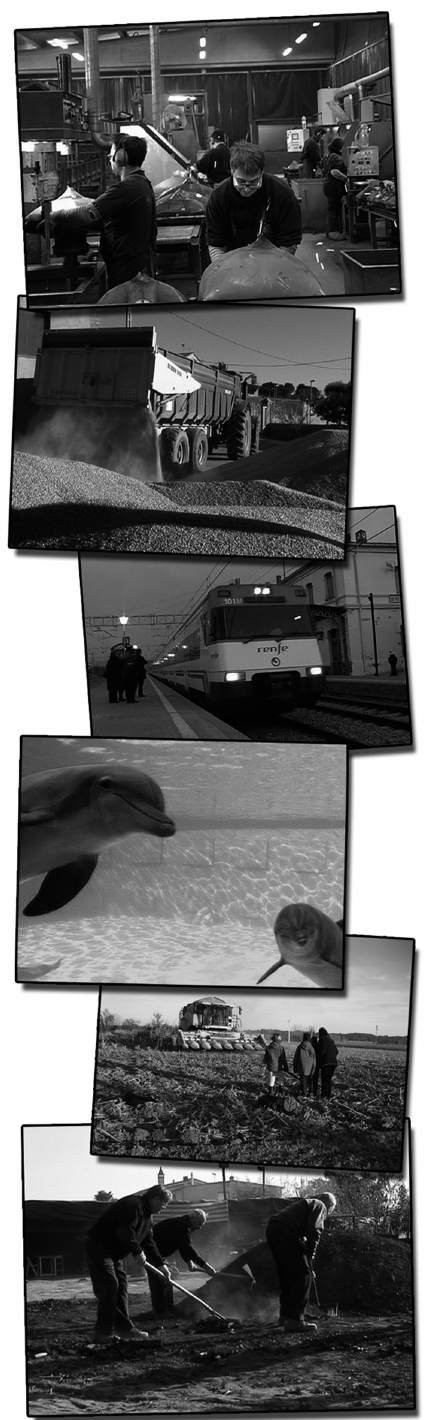
figure 1: the lumière minutes, 1–6 (source: